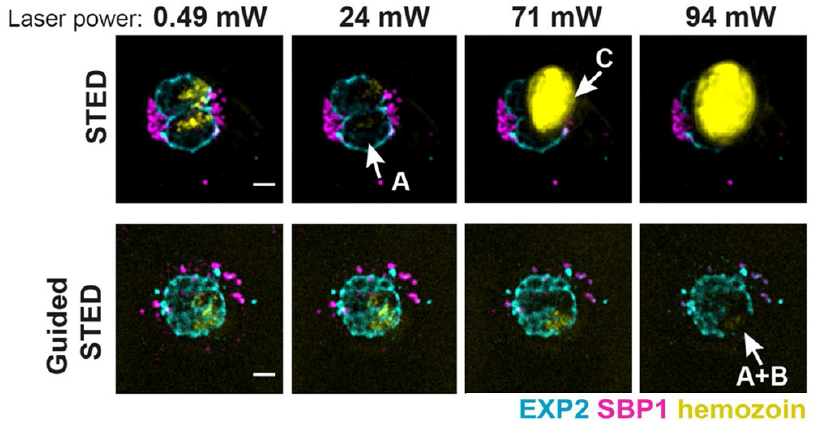
Figure 4. Sample damage at different laser power in STED and guided STED. Reprinted from [85].